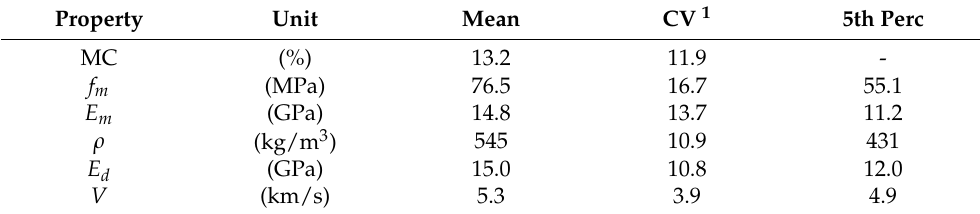
Table 3. Mean values, coefficients of variation (CV) and 5th percentile of physical and mechani- cal properties. MC = moisture content, f m = bending strength; E m = static modulus of elasticity; ρ = density; E d = dynamic modulus of elasticity; V = stress wave velocity. Property Unit Mean